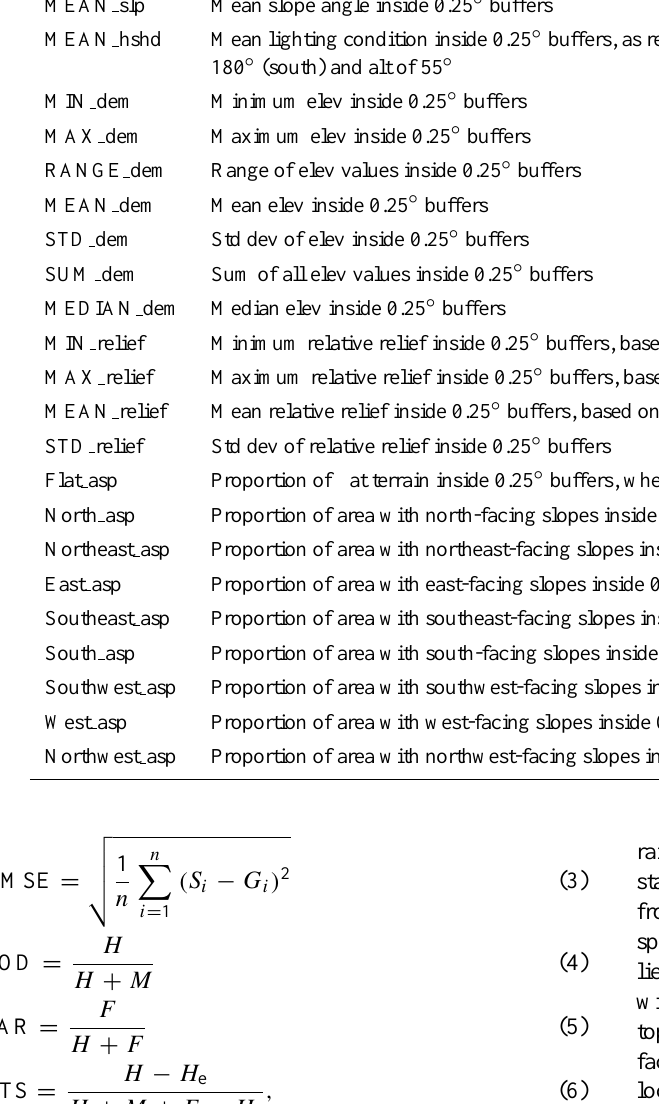
Table 3. Topographic variables and their descriptions.